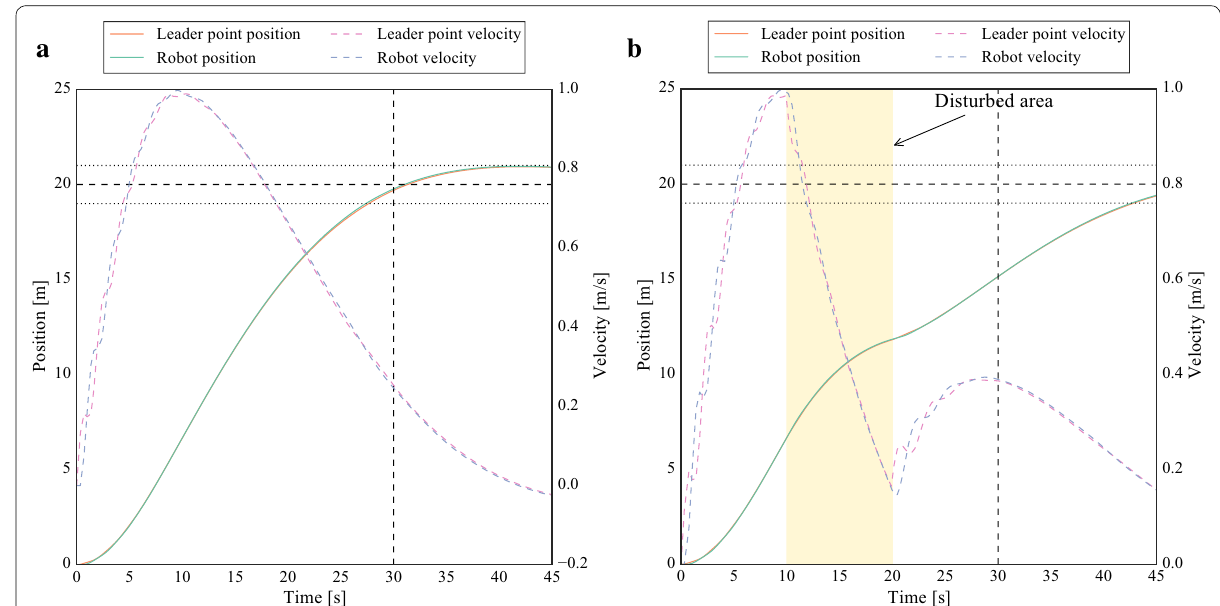
Fig. 3 Examples of the virtual dynamics in one dimension a the robot converged on the goal (20 m) by the settling time (30 s) without disturbance 5 N); b even with disturbance, the robot reach the goal late while smoothly changing its speed. a W/O disturbance, b W/ disturbance ( −